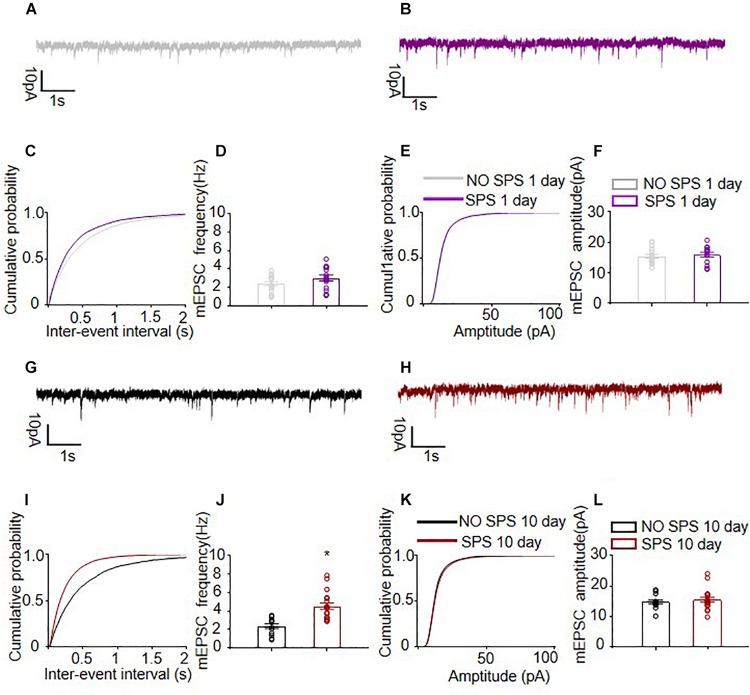
Spontaneous excitatory quantal synaptic transmission onto BLA pyramidal neurons. (A,B,G,H) Representative examples of mEPSCs of different experimental conditions. (C,I) The cumulative probability distribution of mEPSCs inter-event intervals of BLA pyramidal neurons from SPS group and NO SPS group on the first and tenth day after SPS respectively. (D,J) The mEPSCs frequency of BLA pyramidal neurons from SPS group and NO SPS group on the first and tenth day after SPS respectively. (E,K) The cumulative probability distribution of mEPSCs amplitudes of BLA pyramidal neurons from SPS group and NO SPS group on the first and tenth day after SPS respectively. (F,L) The mEPSCs amplitudes of BLA pyramidal neurons from SPS group and NO SPS group on the first and tenth day after SPS respectively. ∗Different from NO SPS group at each post-SPS day, ∗p < 0.05, one-way ANOVA. Data are shown as means ± SEM.